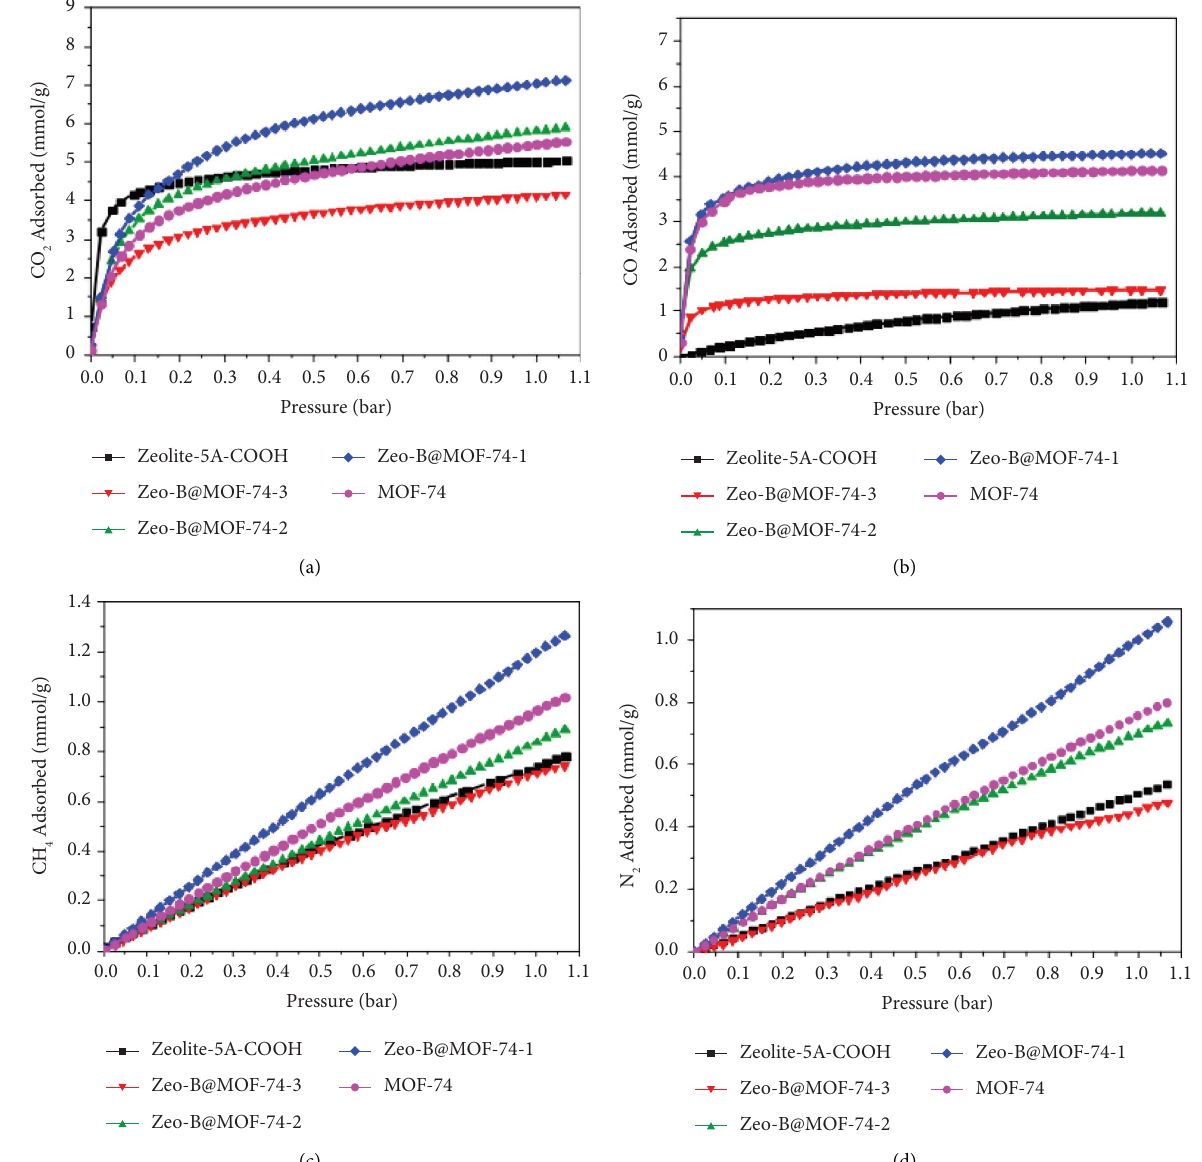
Figure 31: (a) CO 2 , (b) CO, (c) CH 4, and (d) N 2 adsorption isotherms for zeolite-5ACOOH, MOF-74, and the corresponding composites at 25 ° C adopted from